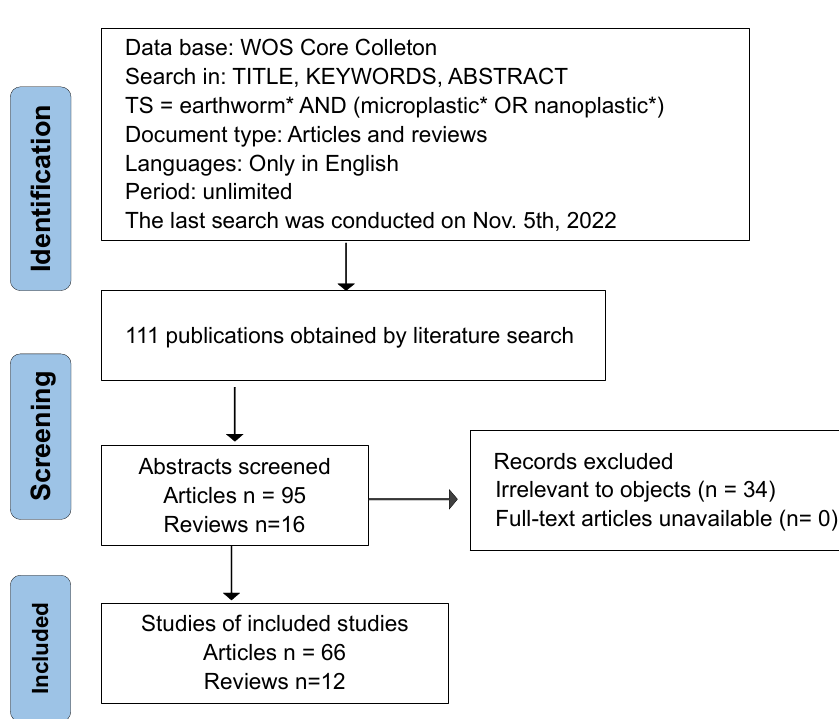
Figure 1. Search strategy implemented to obtain relevant publications for the bibliometric analysis (n denotes the number of publications at the different filtering stages).